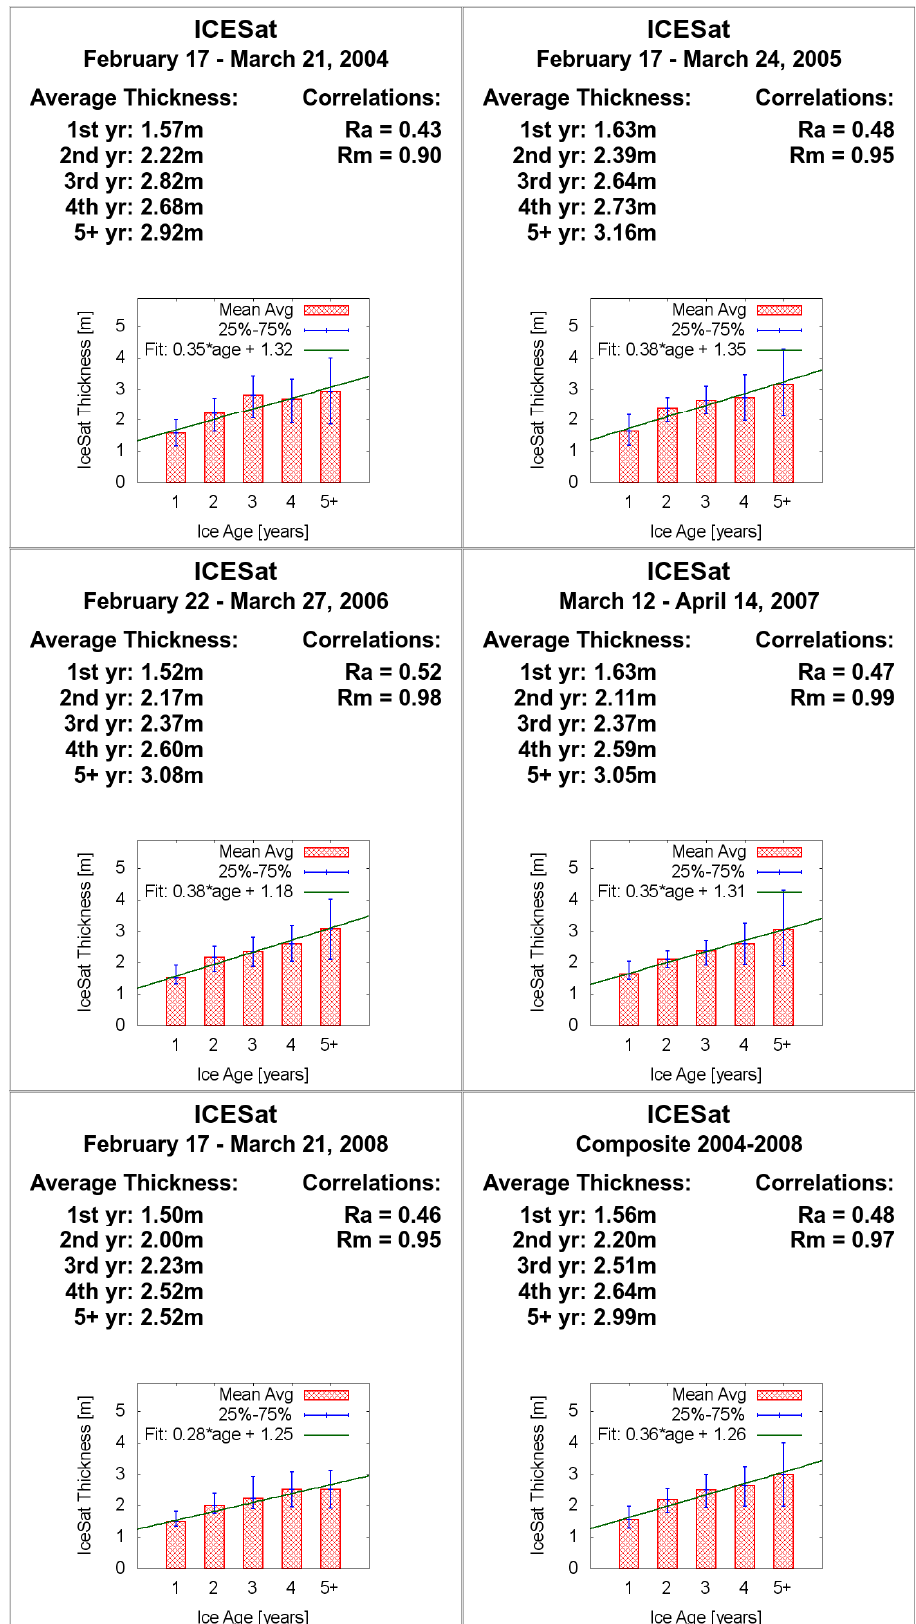
Figure 2. ICESat sea ice thickness vs. ice age.